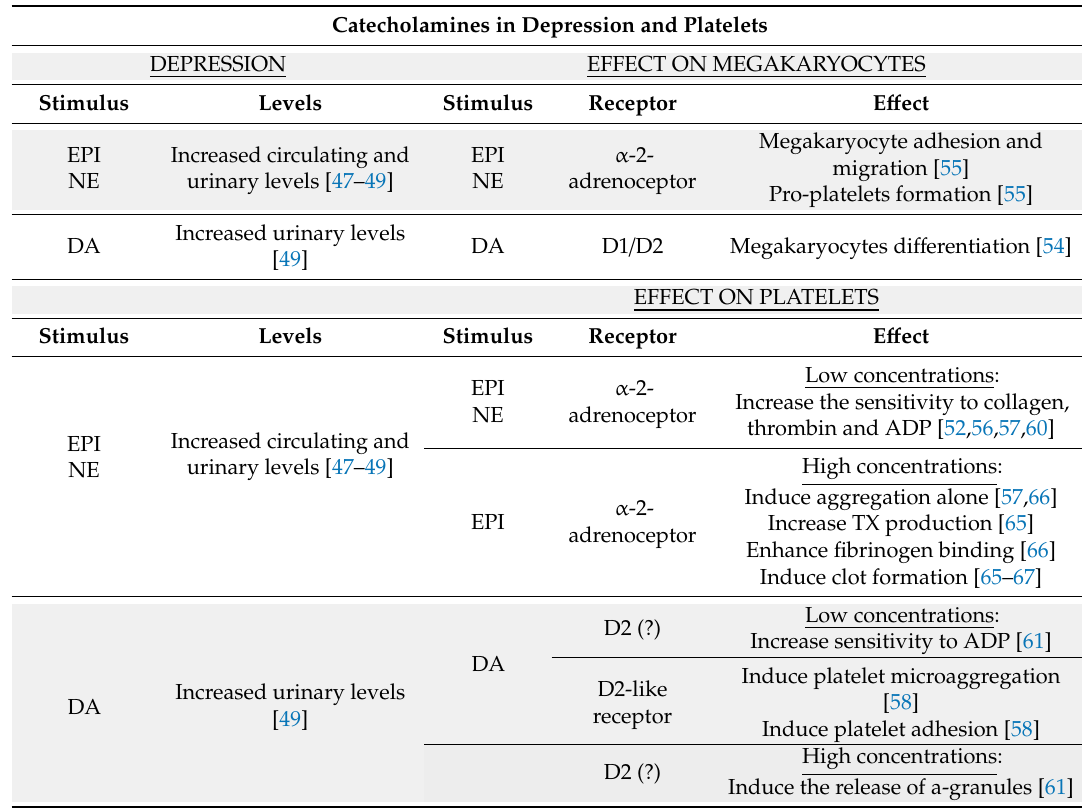
Table 1. Catecholamines levels in MDD and e ff ect on megakaryocytes and platelets. Catecholamines in Depression and